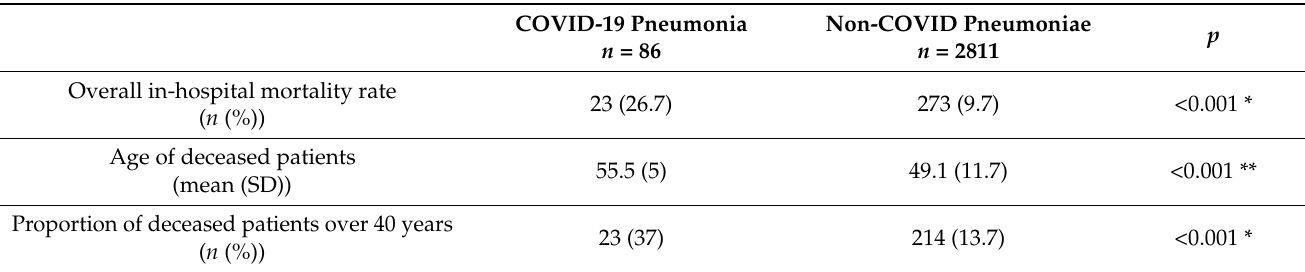
Table 3. Mortality rates in DS patients with COVID-19 and with other non-COVID-19 pneumoniae. COVID-19 Pneumonia